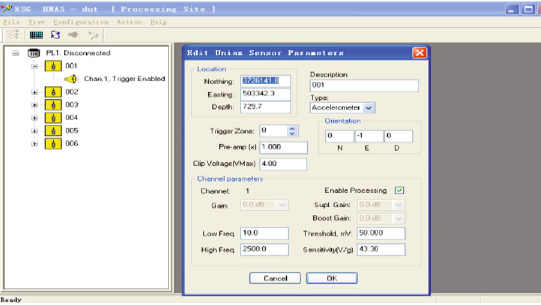
Figure 25: Sensor parameter setting.